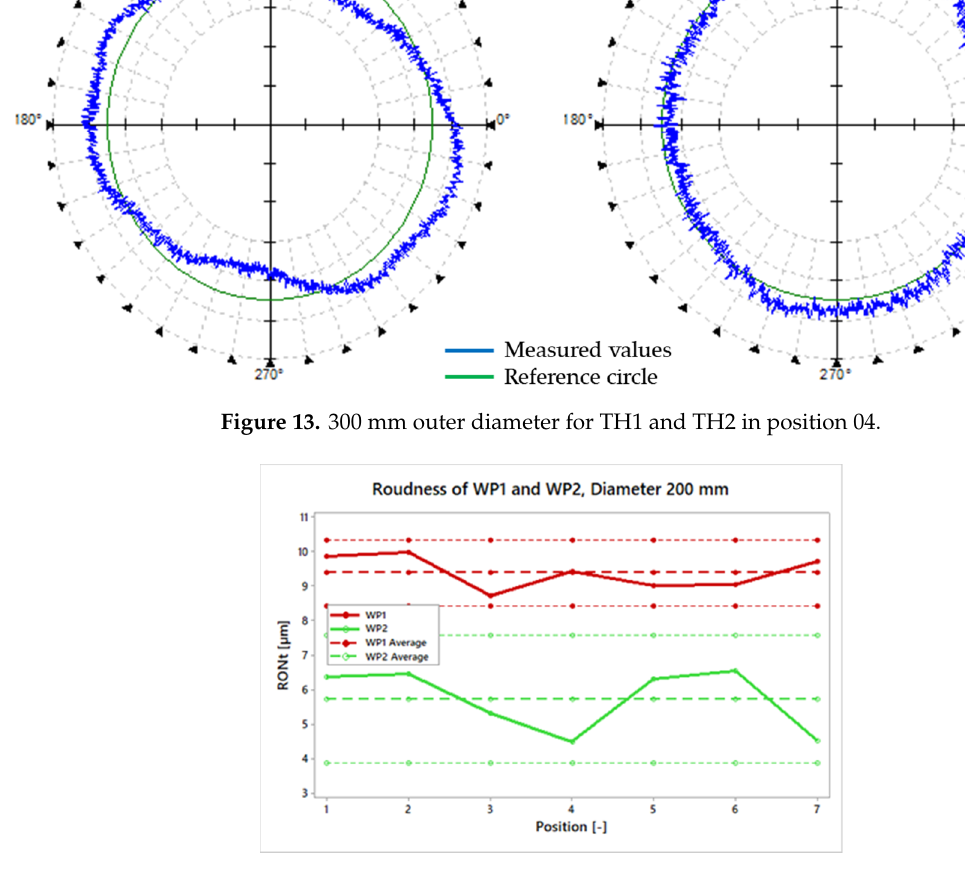
Figure 14. Evaluation of RONt, 200 mm diameter.